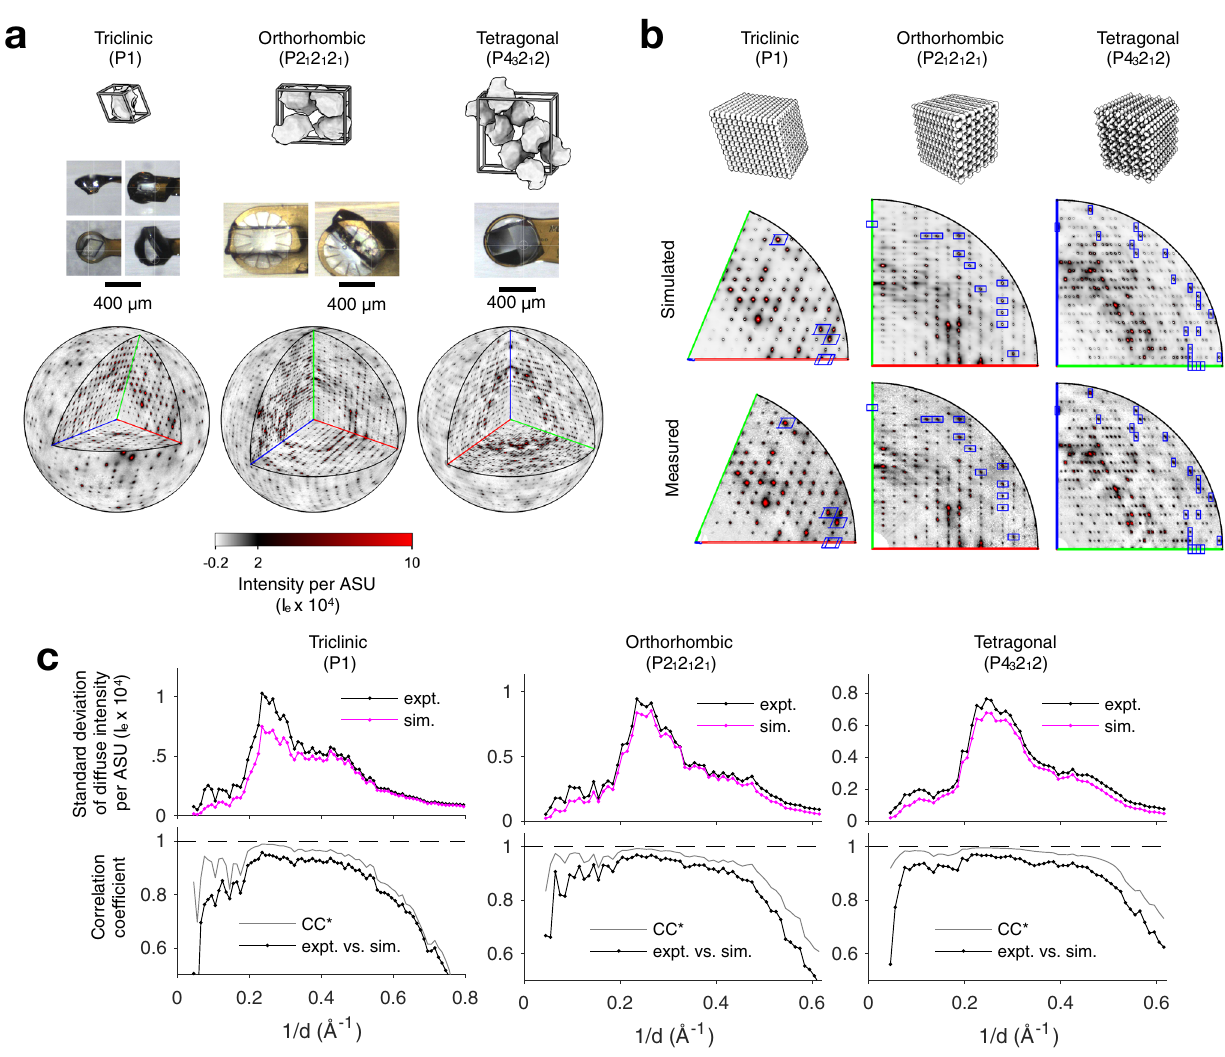
Fig. 3 | Application of GOODVIBES to experimental datasets from lysozyme polymorphs. a TS/RT-MX datasets from lysozyme crystallalized in triclinic, orthorhombic, and tetragonal space groups. The unit cells contain one, four, and eightsymmetry-related chains, respectively (top row). X-raydiffraction datawere acquiredatroomtemperature from multiple largecrystalsto achieve high signal- to-noise for diffuse mapping (photographs of mounted crystals, middle row). Data were processed to produce three-dimensional maps of diffuse scattering. In the bottom row, the variational component of intensity (total minus isotropic) in electronunits( I e )perasymmetricunit(ASU)isshownonasphericalsurfaceat2Å resolution, with the positive octant removed to show three central sections. The axes [ h ,0,0], [0, k ,0], and [0,0, l ], are colored red, green, and blue, respectively. b GOODVIBES was used to fi t a lattice disorder model to each diffuse scattering